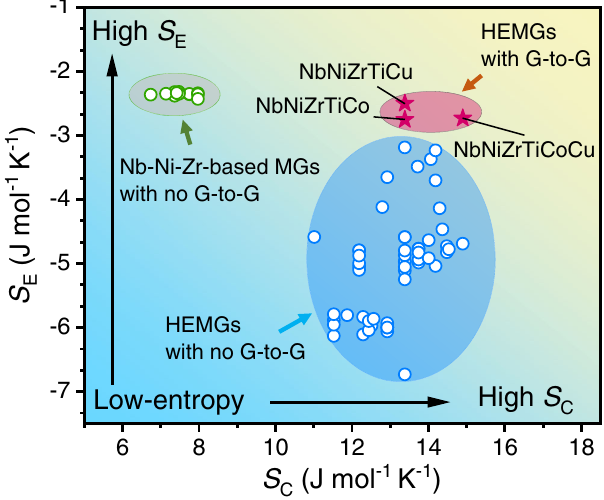
Fig. 6 S E – S C plot. The S C and S E of the HEMGs with glass-to-glass transition, HEMGs without glass-to-glass transition, and the Nb – Ni – Zr- based MGs. The HEMGs with glass-to-glass transition shows high S C and S E . G-to-G: glass-to-glass